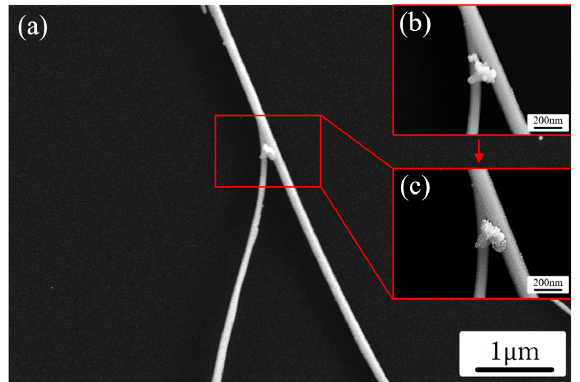
Figure 3. SEM images of the interconnection melting state at 55.25 mJ/cm 2 . ( a , c ) are SEM images of ZnO nanowires-Ag solder interconnection after irradiation; ( b ) SEM images of ZnO nanowires and Ag solder interconnection before irradiation.